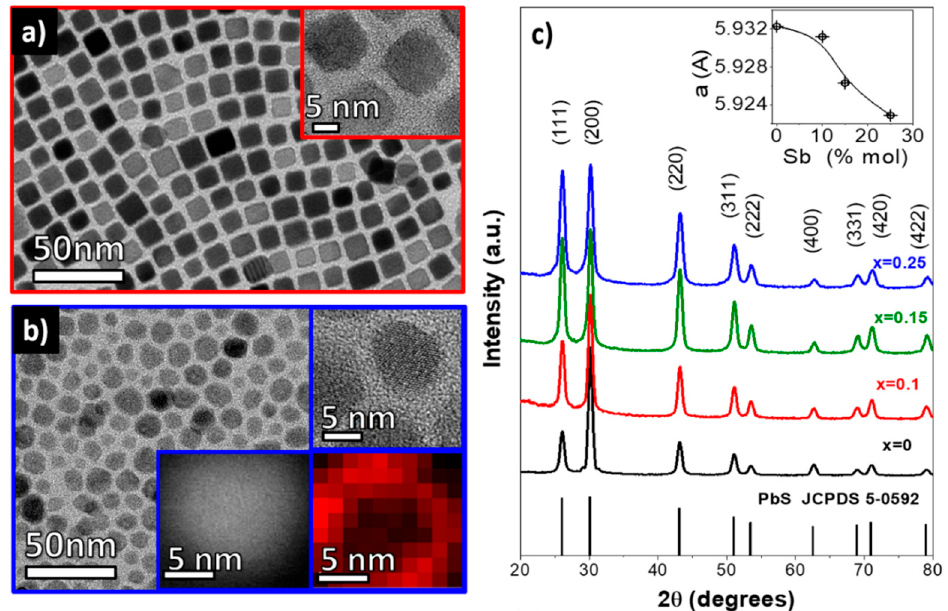
Figure 1. TEM and HRTEM (insets) micrographs of Pb 1 − x Sb x S for x = 0 ( a ) and x = 0.15 ( b ) NCs. A HAADF-STEM image and an EELS elemental map with the distribution of Sb within a single PbS nanoparticle are also shown as insets of ( b ). The EELS map is taken by extracting the signal from the M 4,5 edge of Sb which starts at 528 eV. ( c ) XRD patterns of the Pb 1 − x Sb x S NCs obtained with different nominal dopant concentrations of x = 0, 0.1, 0.15 and 0.25.